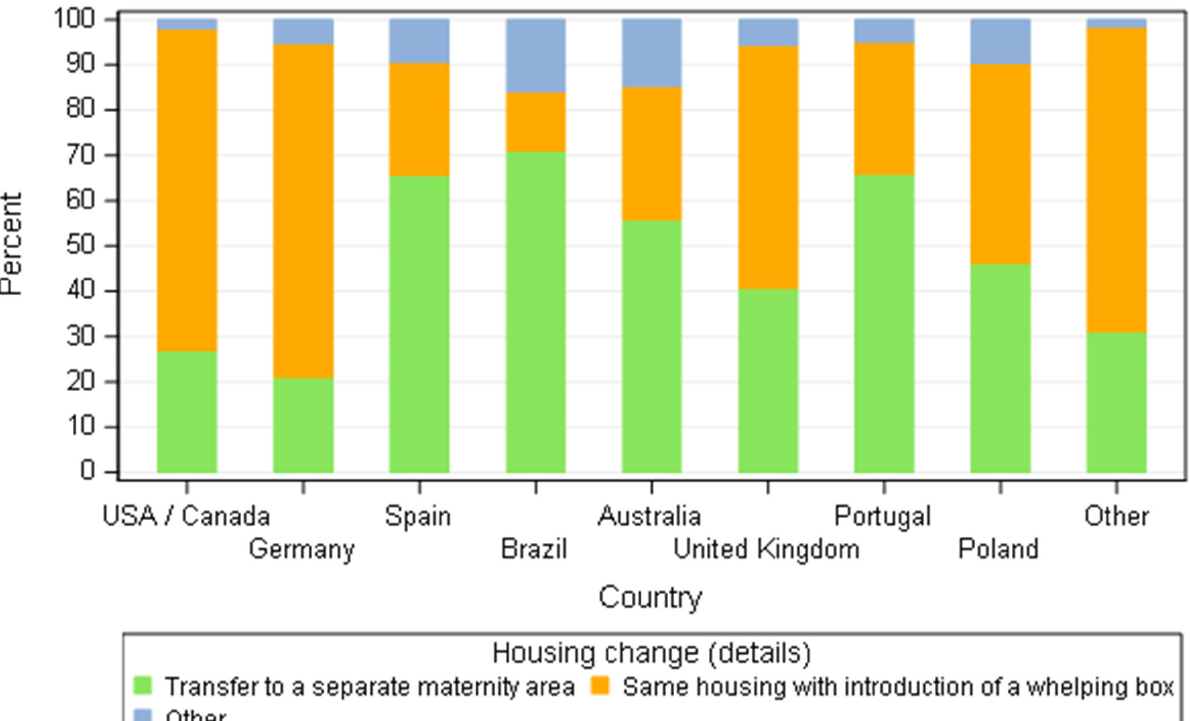
Figure 6. Distribution of bitch housing change around parturition according to dog breeders by country—all responders stating to change the house before parturition ( n = 488).